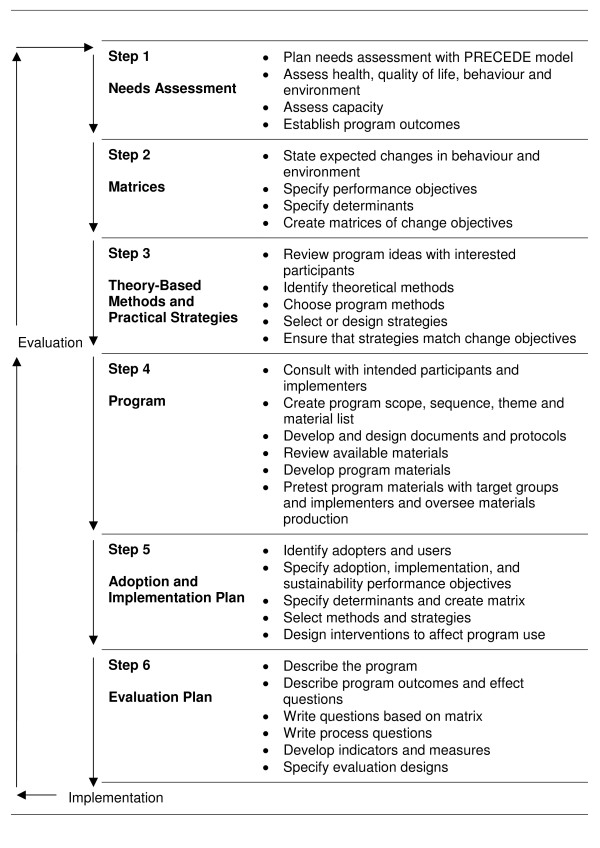
Intervention Mapping protocol [28].